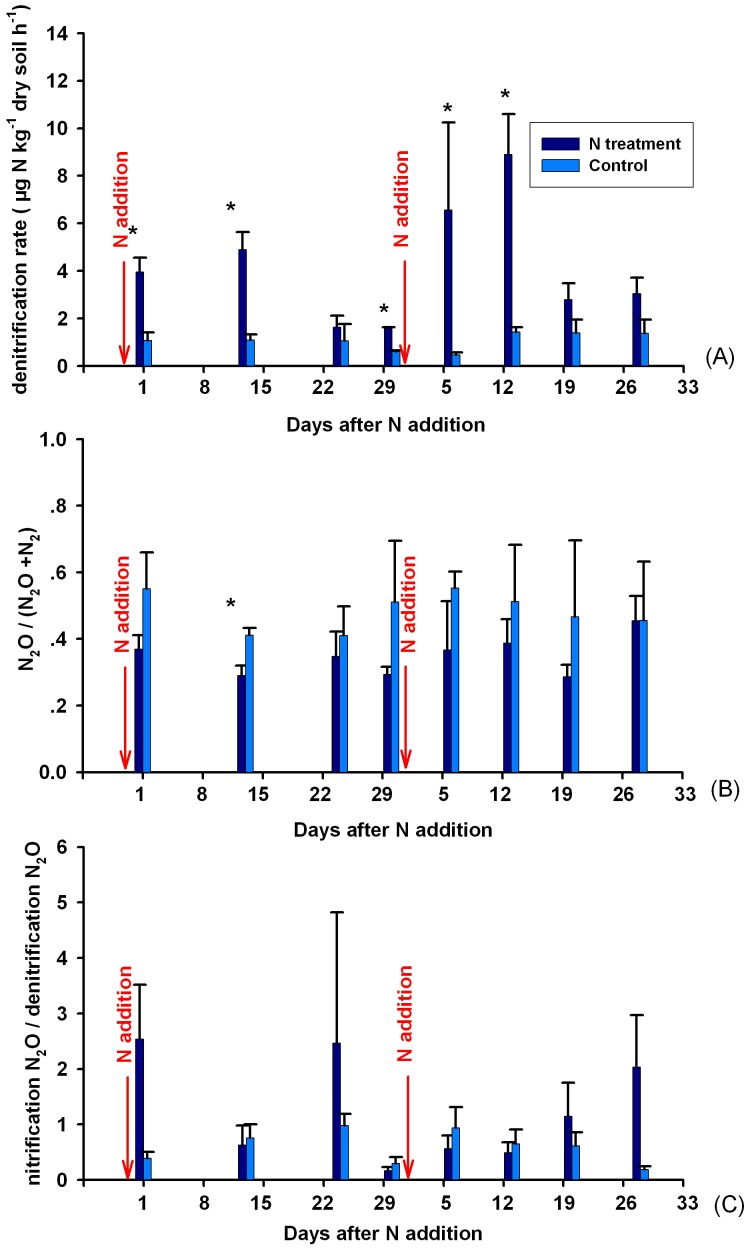
Effect of N addition on denitrification rate (A), N2O: (N2O+N2) ratio (B), and nitrification-derived N2O: denitrification-derived N2O ratio (N2Onit:N2Oden) (C) (n = 3).Arrows represent N addition on that date. * represents significant effect at p = 0.05.